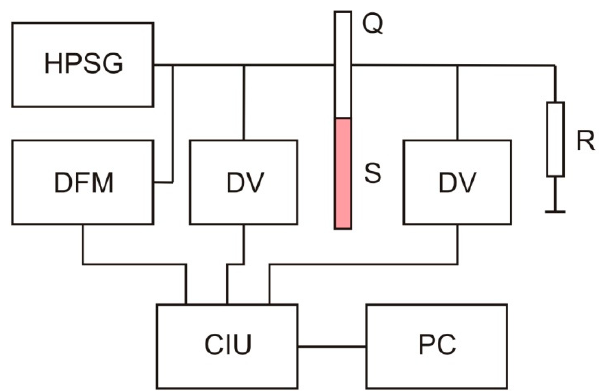
Figure 5. Block diagram of the experimental setup for measuring by the two-component composite vibrator techniques in the ultrasonic frequency range. HPSG is the high precision signal generator; DV are the digital voltmeters; DFM is the digital frequency meter; CIU is the control and interfaces unit; PC is a personal computer; Q is a piezoelectric quartz transducer; S is the sample under study. Composite vibrators were located inside the evacuated cell placed in a helium